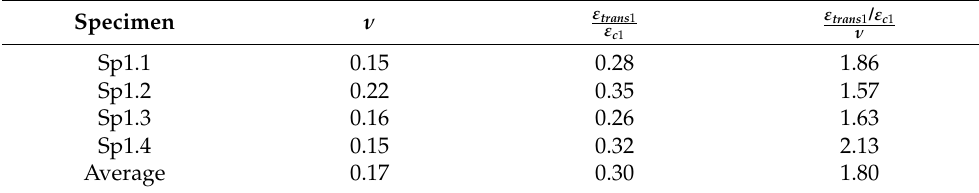
Table 5. Relationship between transverse and longitudinal strains at ULS and Poisson’s ratio values.